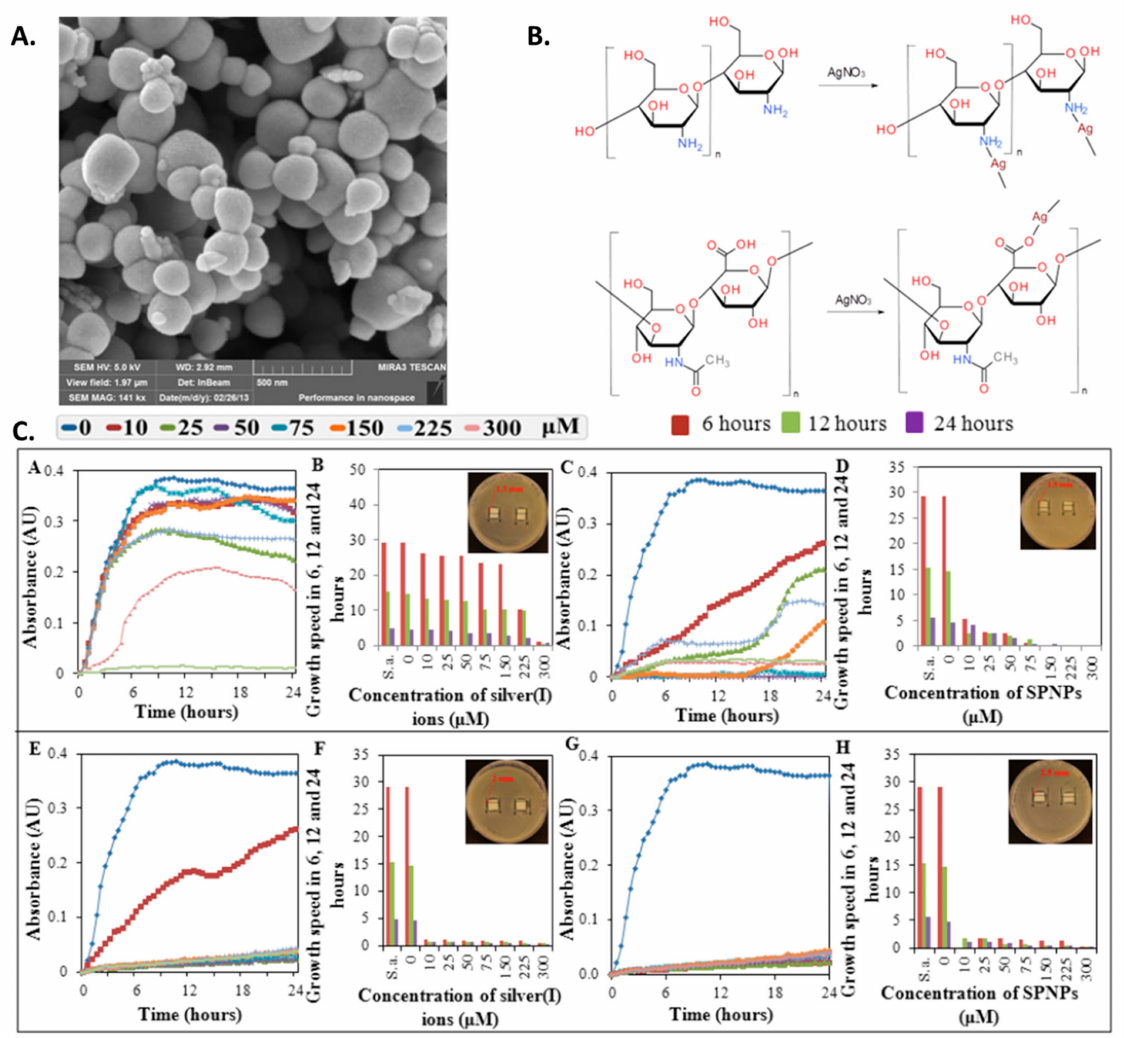
Figure 2. Metal nanoparticles with antiseptic polymers ( A ) SEM image of silver phosphate nanopar- ticles. ( B ) Suggested structures of silver complexes. ( C ) Growth curves (subpanels (A,C,E,G)) as well as growth rate and inhibition zones (B,D,F,H) of S. aureus after application of (A,B)